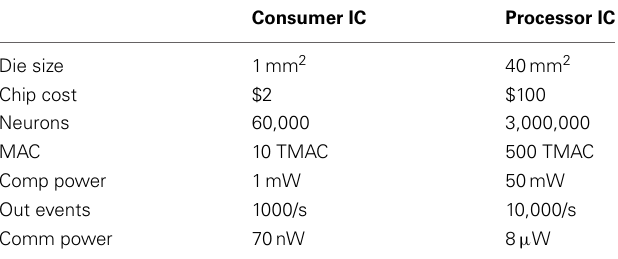
Table 3 | Table of possible specifications for commercial Neuromorphic